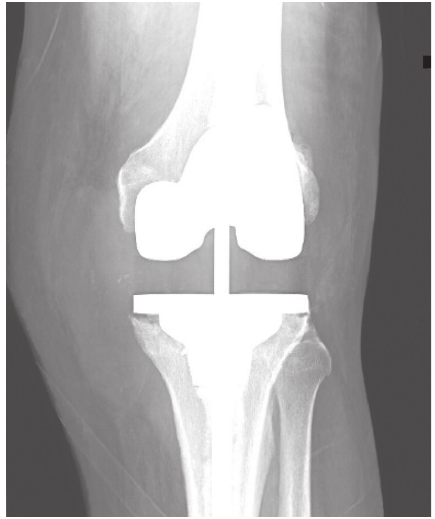
Figure 1: X-ray of the left knee demonstrating perihardware lu- cencies at the level of the tibial